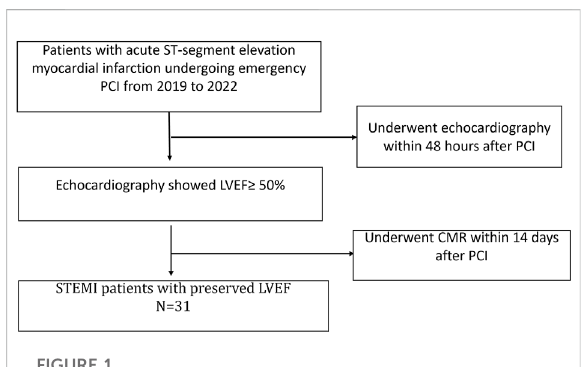
FIGURE 1 Flowchart of recruitment for patients. PCI, percutaneous coronary intervention; LVEF, left ventricular ejection fraction; CMR, Cardiac Magnetic